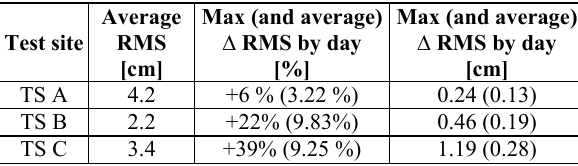
Table 3. Summary of average RMS by site and the maximum (average in parenthesis) RMS increase by day, calculated with respect to the day that provides the minimum RMS. Table 3 summarizes the average RMS obtained for each site